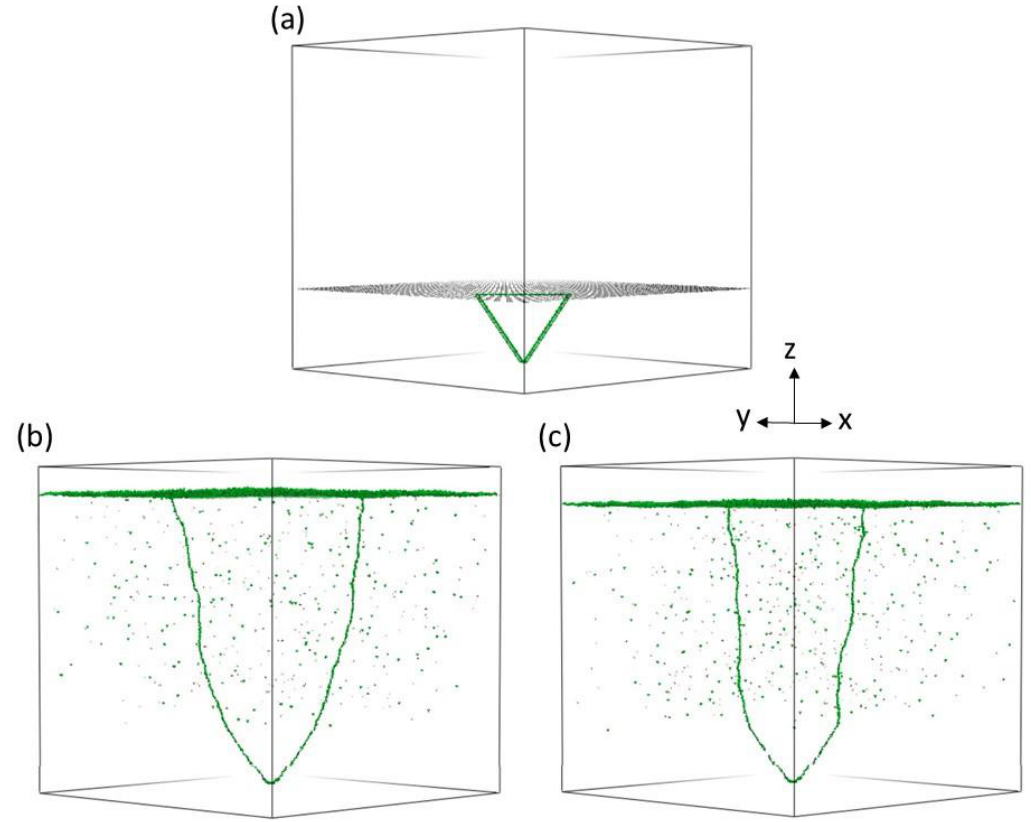
Figure 9. Simulation of SiC PVD growth starting from a defective nucleus. ( a ) Initial SF nucleus. Only uncoordinated atoms are shown (i.e., vacancies, SF borders and surface). Si atoms green spheres, C atoms gray spheres. Snapshot of the KMC-MulSKIPS simulated evolution of triple SF defects for the growth conditions of ( b ) sample A and ( c ) sample E (i.e., the lowest and the highest growth rate among the 5 conditions discussed here) obtained after similar thicknesses of the grown layer. Only uncoordinated atoms are shown (i.e., vacancies, SF border and surface). As a result of the expansion, the length of the intersection of the d efect’s nucleus and the initial substrate surface ( 𝐿 𝑆𝐹 ) increases. In Figure 10, we plot the average value of the 𝐿 𝑆𝐹 obtained in the six simulated replicas after a ≈ 50 nm thickness of growth for the SiC layer. The eventual differences between lower and higher values of the source tempera- ture are relatively small, and they should be confirmed by additional extended statistical analyses.